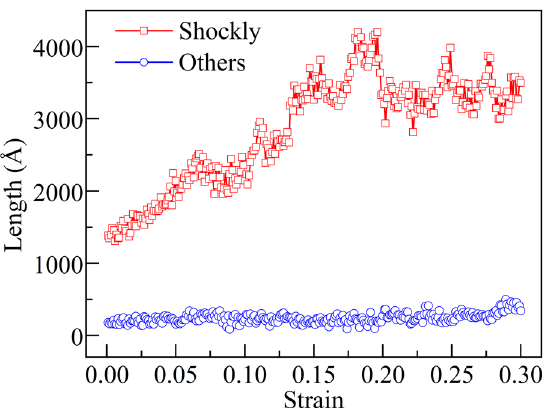
Figure 9. Sum of the lengths of dislocations (Shockley dislocations and other types) in independent multi-twinned regions. FCC structures are colored blue, and HCP structures are colored orange, other atoms are colored gray.